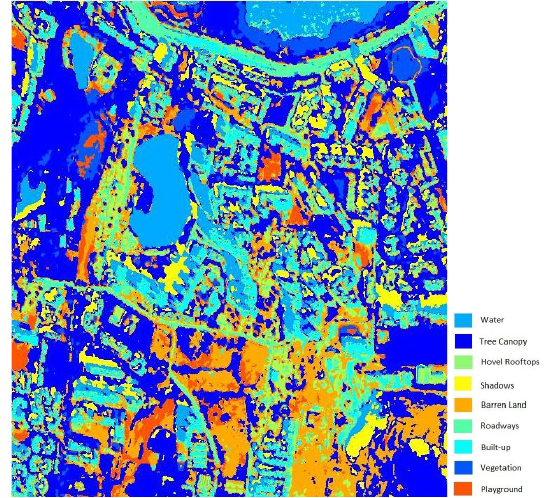
Figure 3: Classified output using